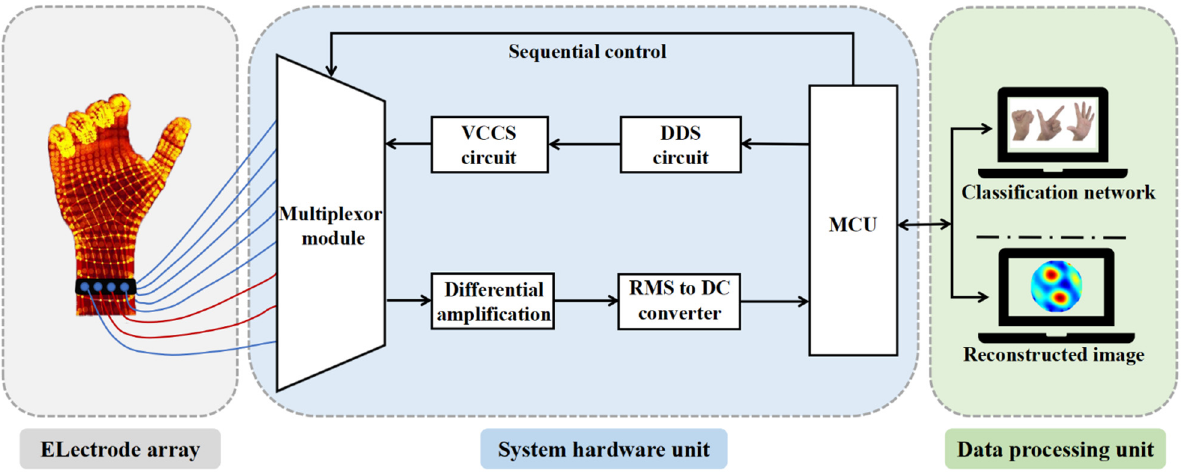
Figure 1. The overall structures of the electrical impedance tomography (EIT) system for gesture